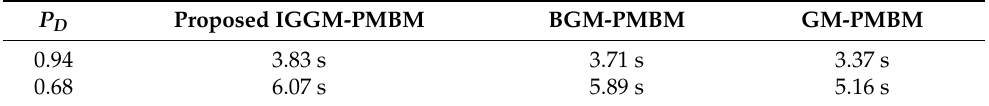
Table 3. Average computational times.